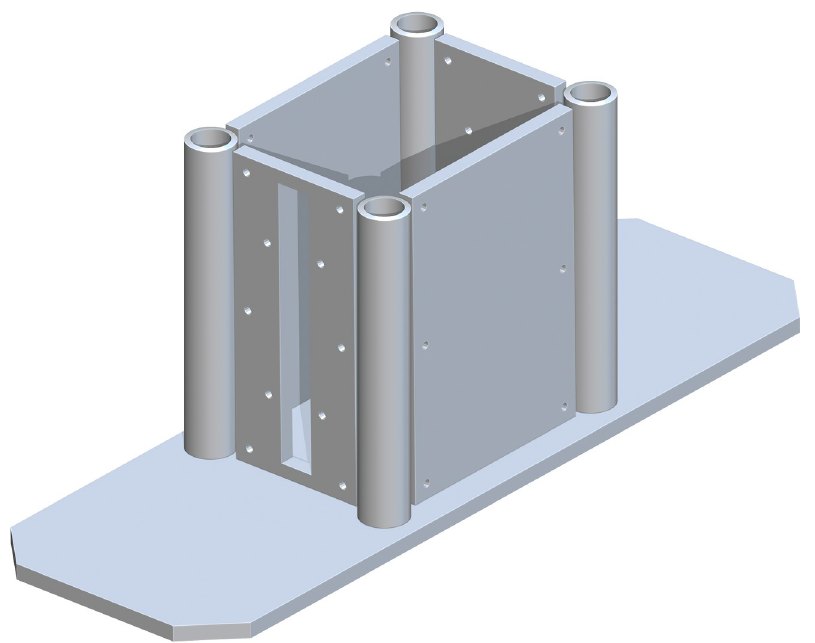
Fig 2. Adding four Base 3in Pipes to the corners of the Base